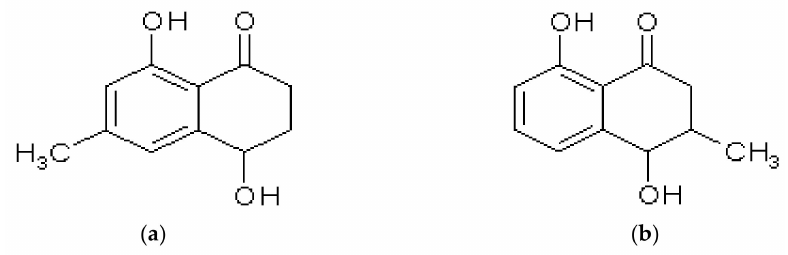
Figure 6. Structure of shinanolone ( a ) and isoshinanolone ( b